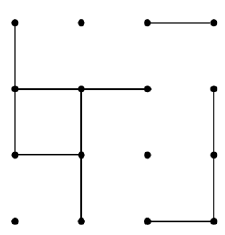
Figure 3 . An example of a random subset X of bonds on a 4 and c ( X ) = 6. Notice that isolated points count as